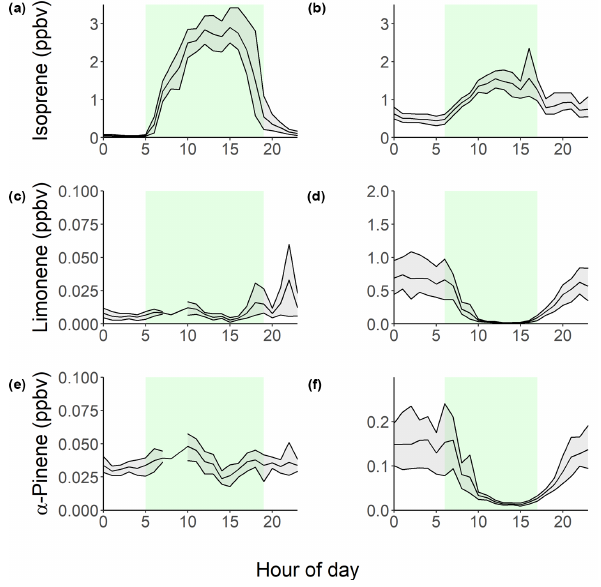
Figure 3. Diurnal variations across the pre- (a, c, e) and post- monsoon (b, d, f) campaigns of isoprene (a, b) , limonene (c, d) , and α -pinene (e, f) . The shaded grey area represents the 95% con- fidence interval. The shaded green area represents the times driven by biogenic emissions, as defined by the isoprene